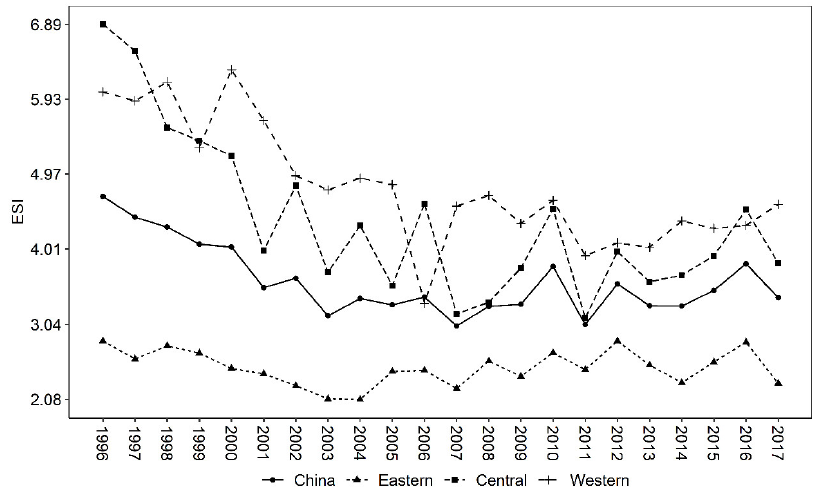
Figure 4. Trends in China’s agricultural ESI, 1996–2017. Table 6. The provincial comparison results of China’s agricultural